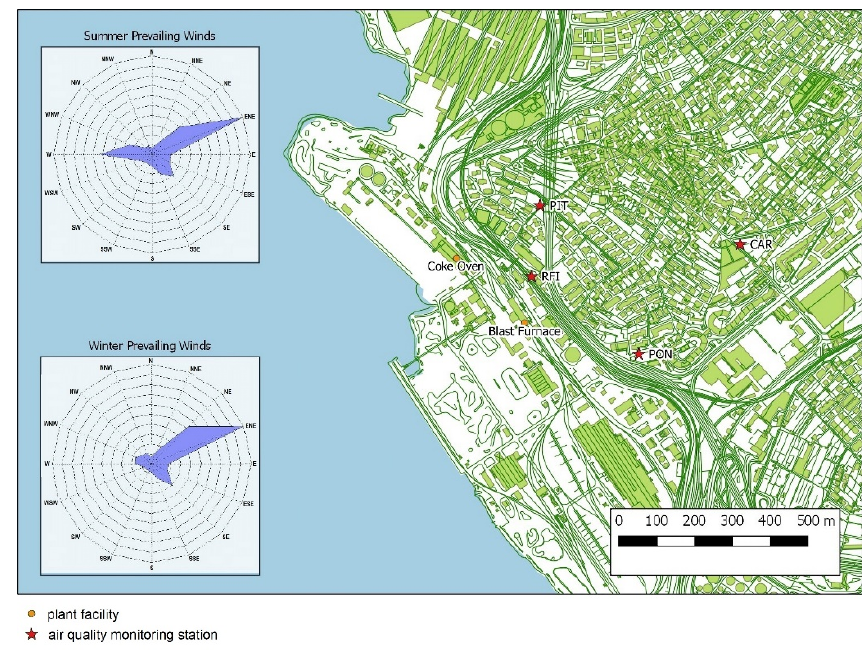
Figure 2. Location of the Servola Ironmaking Plant in Trieste (45°37 ′ 14.8 ″ N 13°46 ′ 48.4 ″ E). On the industrial site, two twin BFs were installed, but only one (AFO3) was in operation. After that, the blast furnace has been stopped because of the reindustrialization of the harbor area. The characteristics of AFO3 are listed in Table